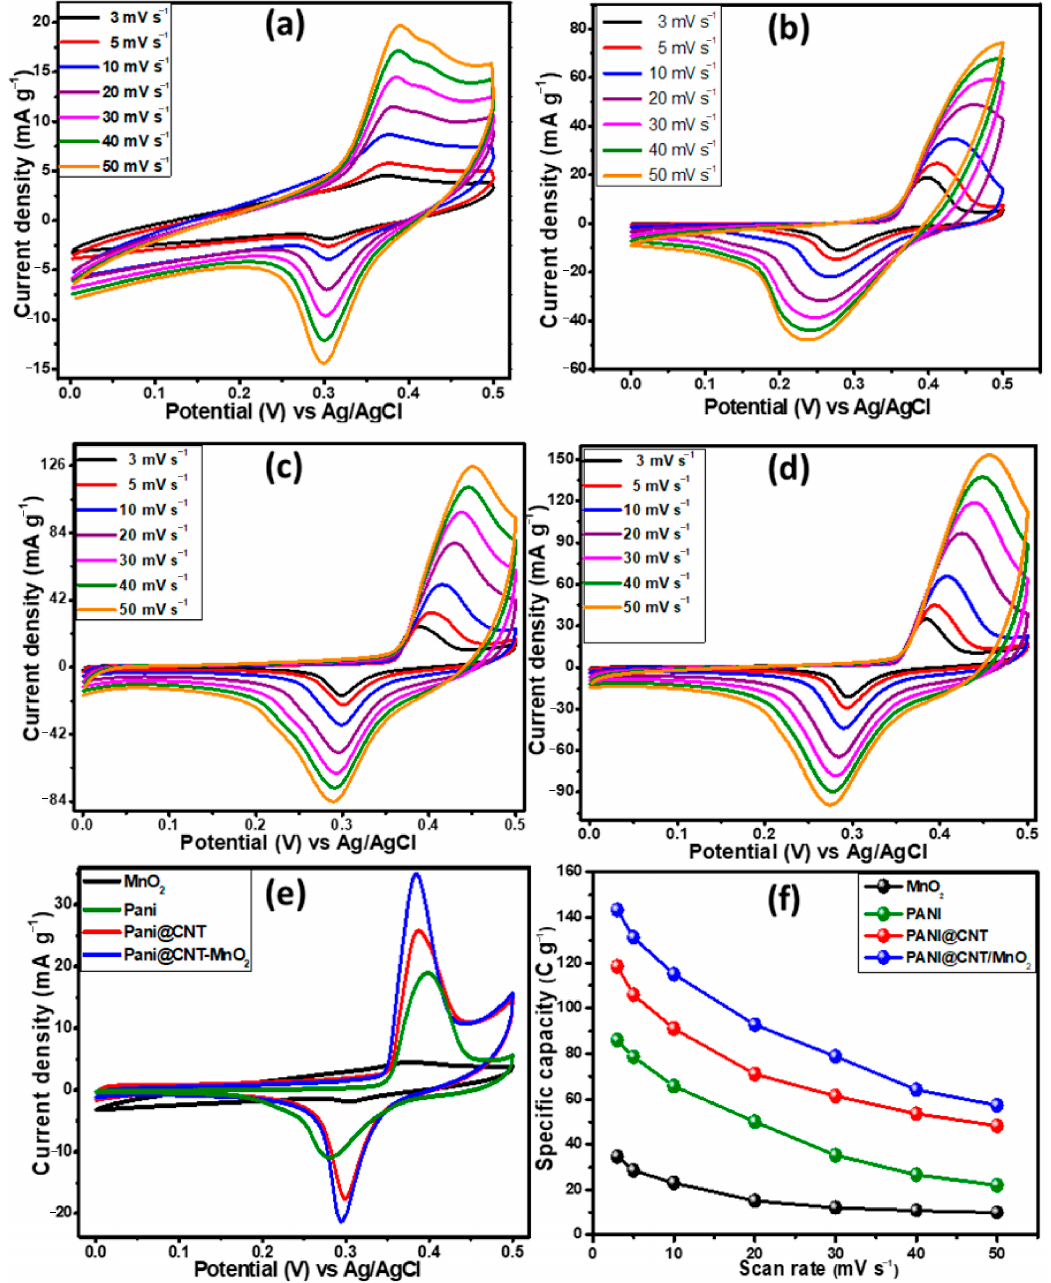
Figure 5. Cyclic voltammetry (CV) curves of ( a ) pristine MnO 2 nanorods ( b ) fibrous PANI, ( c ) PANI@CNT binary composite, ( d ) PANI@CNT / MnO 2 measured at varied scan rates, ( e ) CV curves to compare the electrochemical performance of all variants recorded at 3 mV s − 1 , and ( f ) scan rate vs. specific capacity plot for all variants.